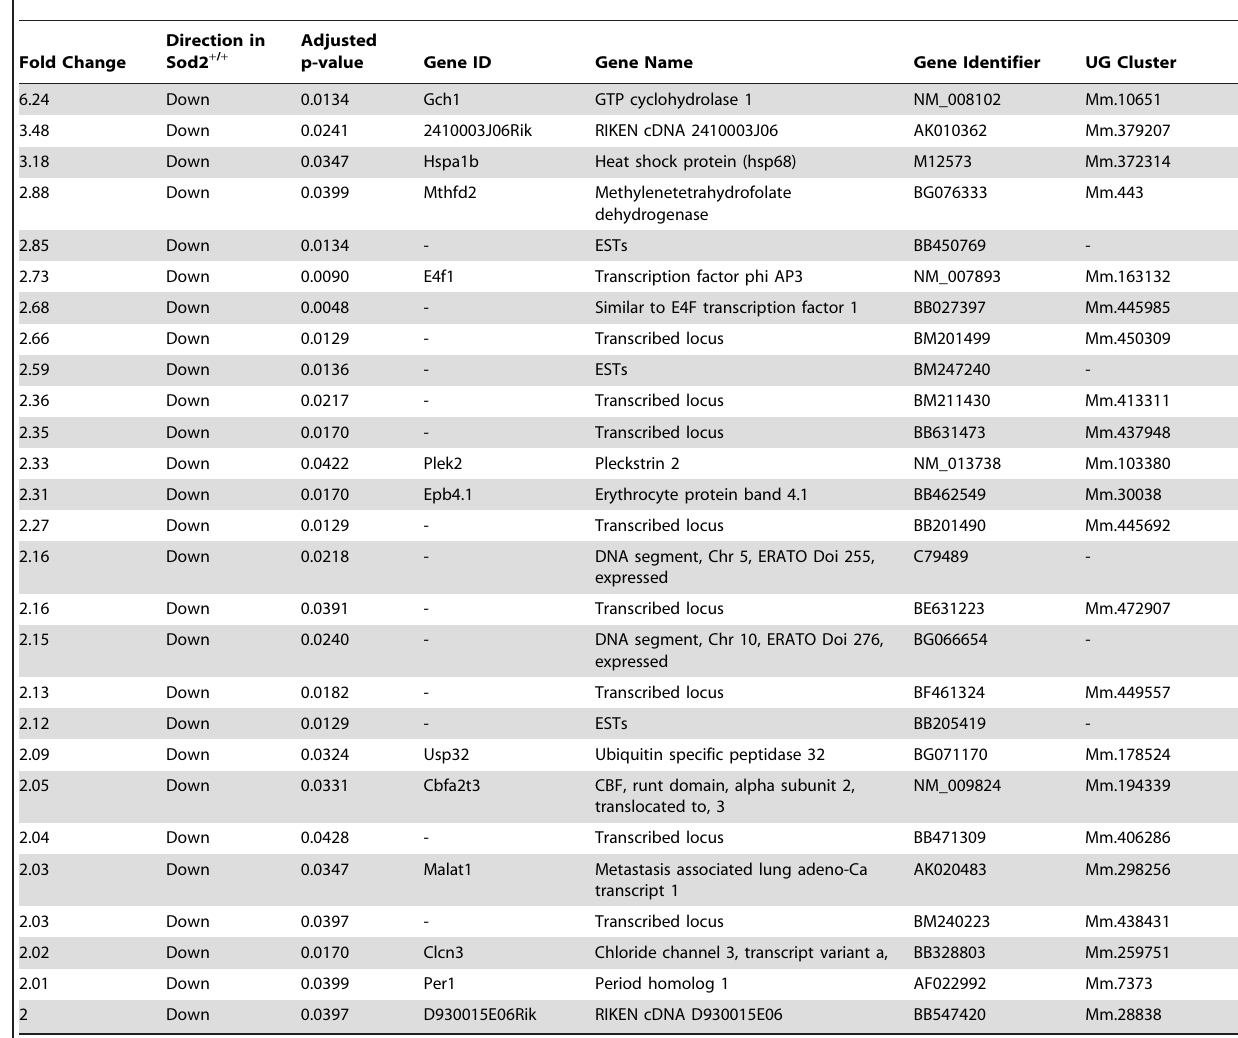
Table 1. List of Expressed Erythroblast Transcripts/Genes with Decreased Expression in Sod2 + / + Compared to Sod2-/- Cells.